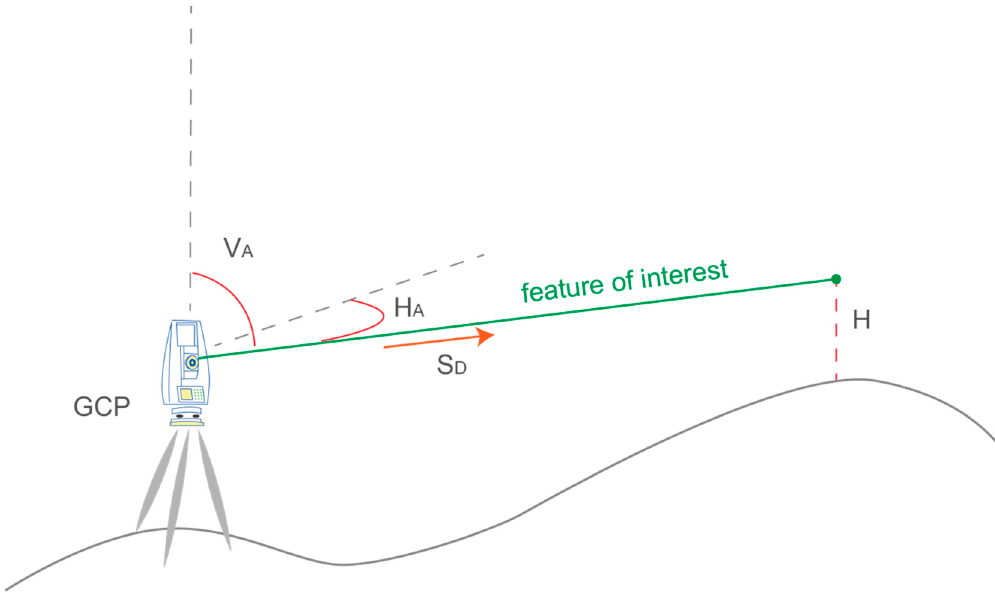
Figure 3. Observable quantities of the feature of interest.